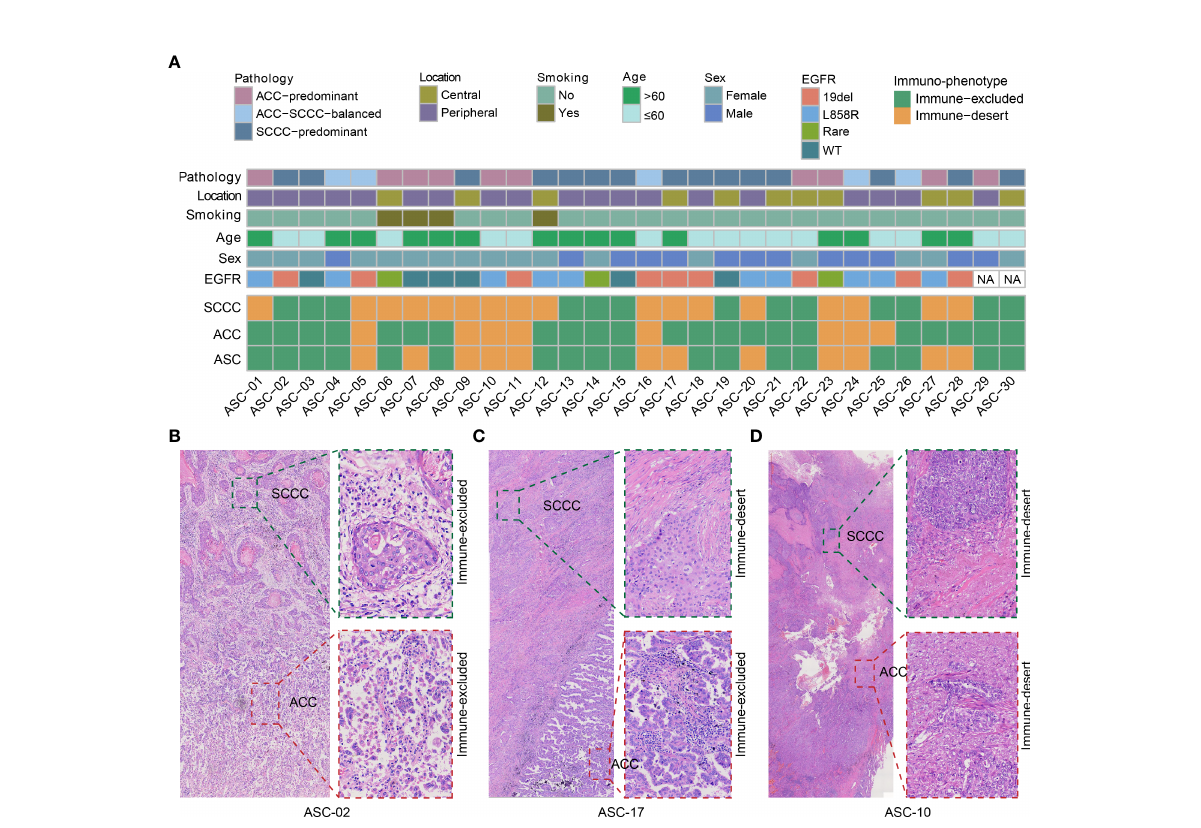
FIGURE 1 Patient characteristics and immunophenotypes of lung adenosquamous carcinoma (ASC). (A) Demographic and clinicopathological characteristics and immunophenotypes based on the density and localization of tumor-in fi ltrating lymphocytes. All adenocarcinoma component (ACC) and squamous cell carcinoma component (SCCC) samples show immune-excluded or immune-desert immunophenotypes. ( B – D ) Images of classical